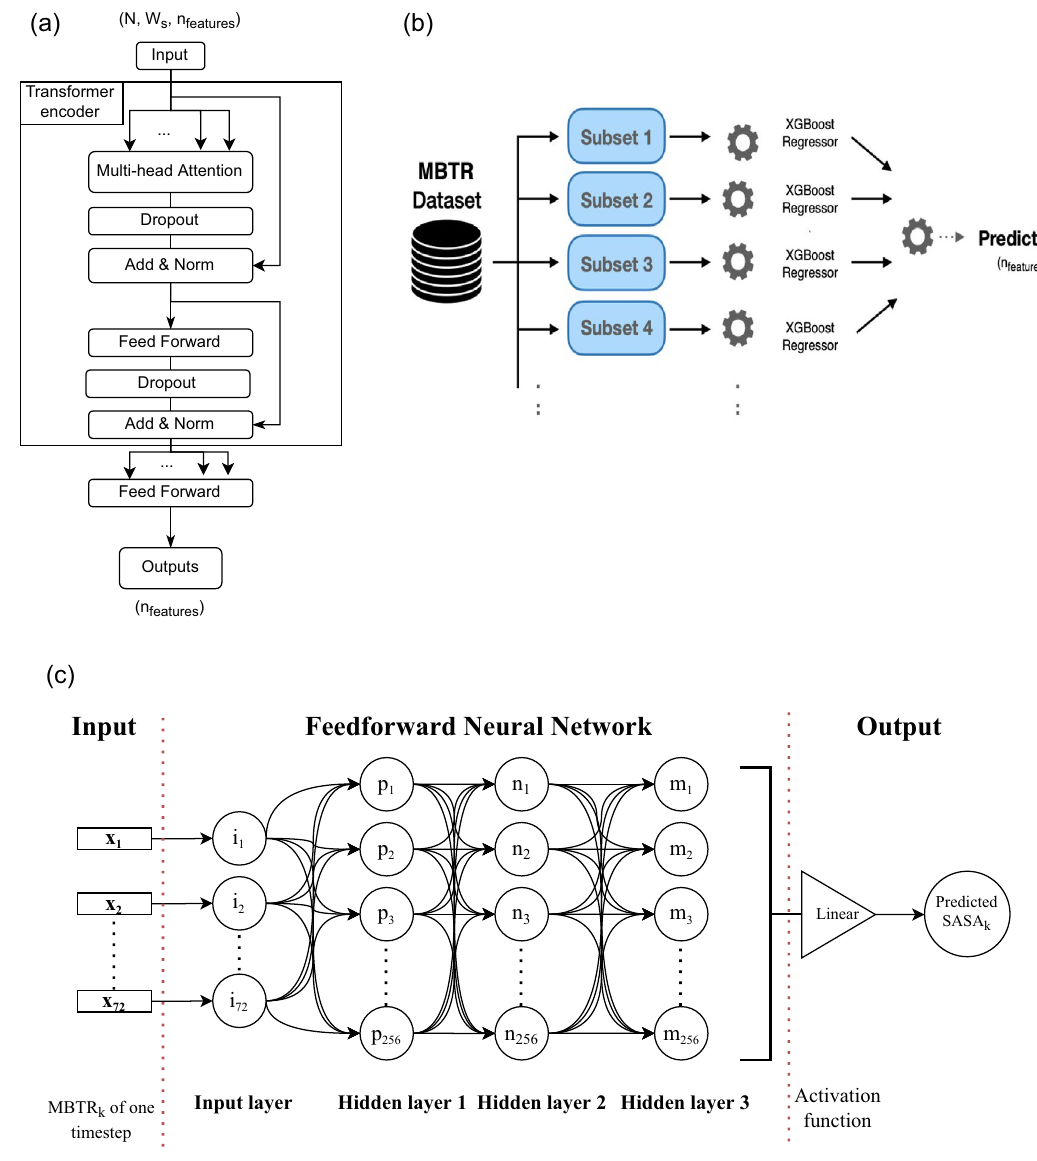
Figure 6. ( a ) Block diagram of the transformer model. Four different layers are used in the transformer model 59 . Multi-head attention allows the model to jointly attend to information from different representation subspaces at different positions. The dropout layer prevents overfitting, the normalization layer improves the training speed for various neural network models, and after normalization, the results are added to the input. The feedforward layer is a nonlinear mapping from an input pattern x to an output vector y . ( b ) Block diagram of the ensemble approach. The MBTR vector batches are split for each of the features, and all 72 subsets of data are used with an XGBoost regression model. The predictions from each model are then combined to produce the n features -length output. ( c ) Block diagram of the SASA model. The 72 MBTR features at timestep k are passed to the i nodes of the input layer. The information in the input layer nodes is then passed to all the nodes of the hidden layers with p , n and m nodes interconnected in such a way that each node in the current layer is connected to every other node in the previous layer. The output is a single scalar value representing the SASA at timestep k